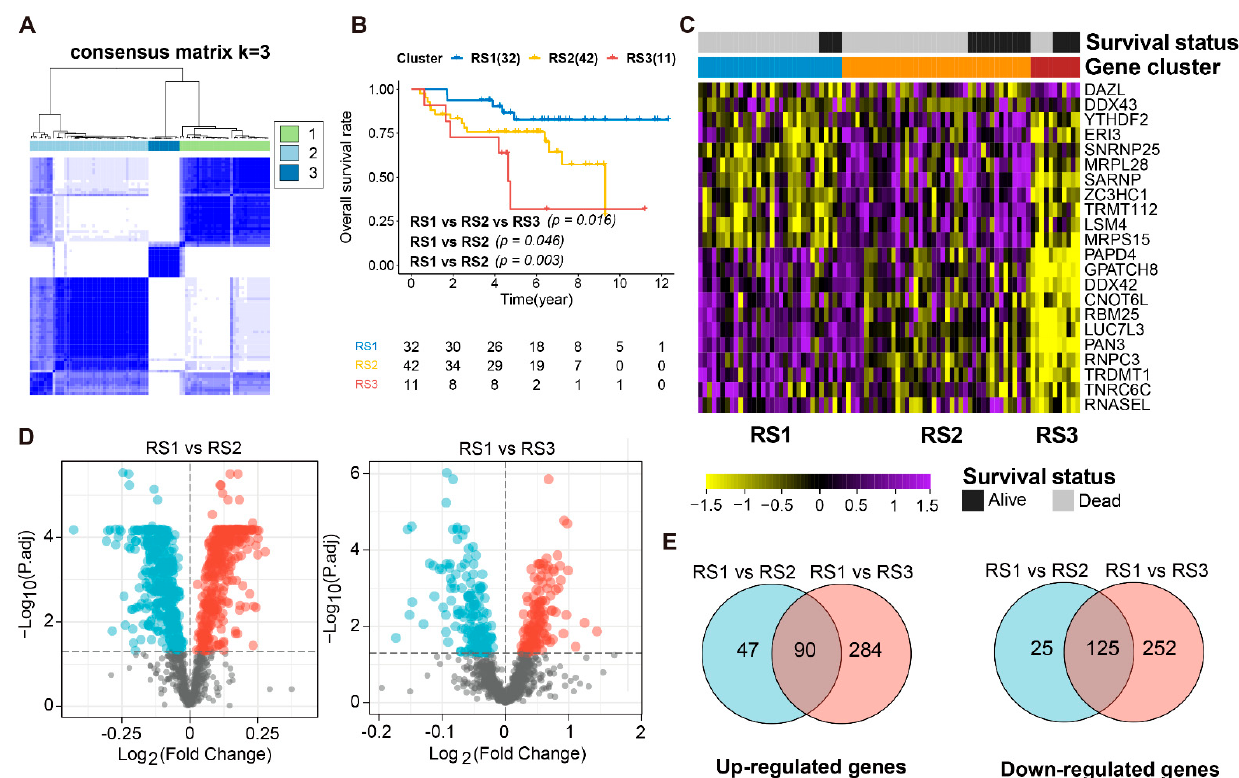
Figure 1. DERBP identification and the transcriptional subtypes of ES ( A ). Consensus matrices of identified clusters (k = 3). ( B ). Kaplan-Meier curves show the overall survival in ES patients among the three subtypes ( p = 0.016, p = 0.045, p = 0.003 for RS1 vs. RS2 vs. RS3, RS1 vs. RS2 and RS1 vs. RS3, respectively). ( C ). Abundances of 22 DERBPs (identified in dead ES patients) in the three RSs. ( D ). Expression profile of RBPs between RS1 versus RS2 and RS1 versus RS3, respectively. Red and blue dots represent upregulated and downregulated RBPs in RS2 or RS3, respectively (FDR < 0.05). ( E ). Overlap up-regulated and down-regulated DEREPs between RS1 versus RS2 and RS1 versus RS3.